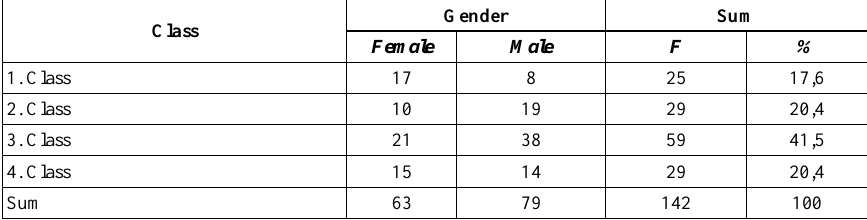
Table 1. Öğrencilerin demografik